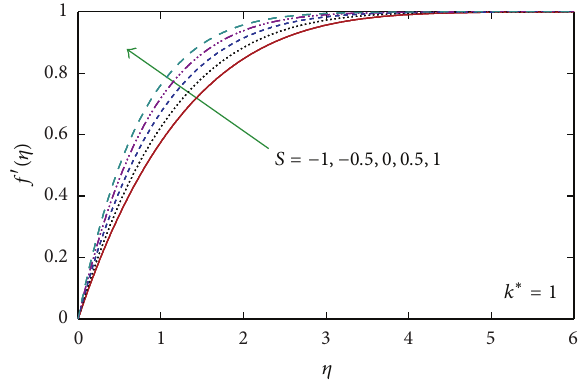
Figure 4: Velocity profiles 𝑓 󸀠 (𝜂) for different values of 𝑆 . concentration profiles are plotted in Figures 4, 5(a), and